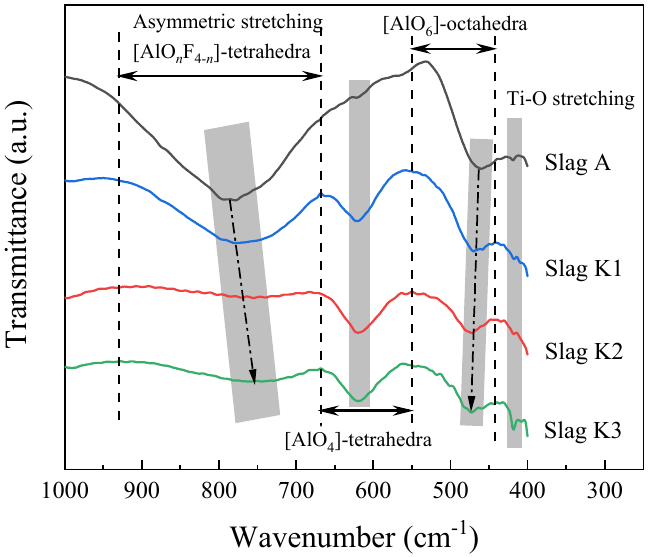
Figure 5. The TG (solid line) and DSC (dotted line) curves of the slag K4 and K5.